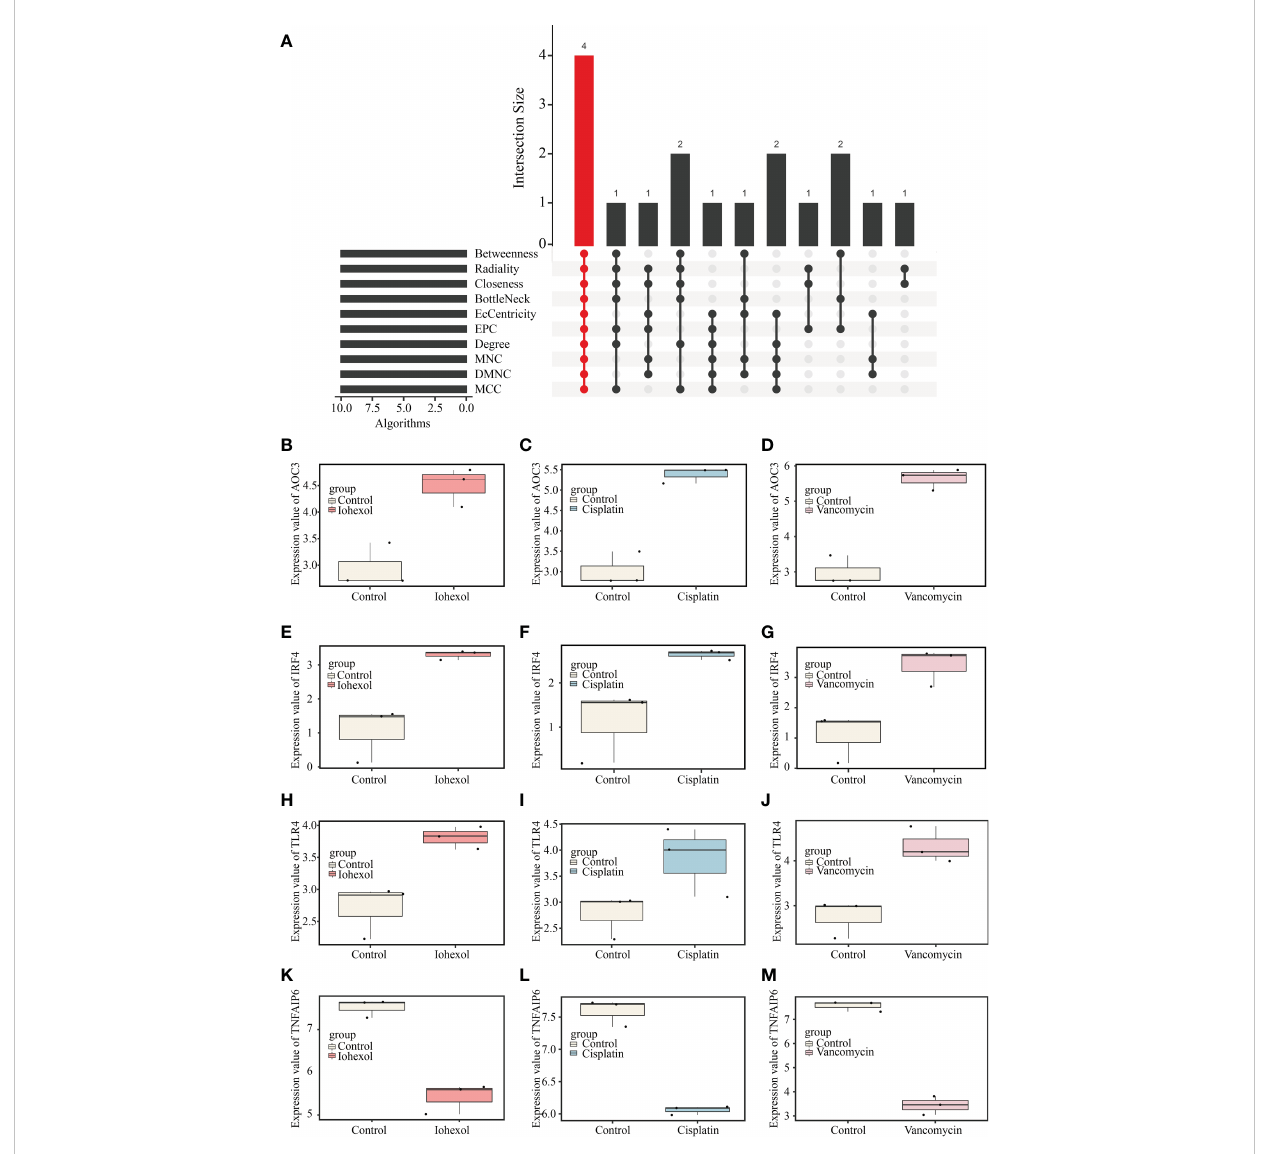
FIGURE 4 Identi fi cation of hub genes and their expression in three AKI datasets. (A) Four hub genes (AOC3, IRF4, TLR4 and TNFAIP6) were identi fi ed by intersection of co-DEGs from 10 algorithms, namely, MCC, DMNC, MNC, Degree, EPC, BottleNeck, EcCentricity, Closeness, Radiality, and Betweenness. (B – D) The expression value of AOC3 in iohexol, cisplatin or vancomycin datasets compared with controls. (E – G) The expression value of IRF4 in iohexol, cisplatin or vancomycin datasets compared with controls. (H – J) The expression value of TLR4 in iohexol, cisplatin or vancomycin datasets compared with controls. (K-M) The expression value of TNFAIP6 in iohexol, cisplatin or vancomycin datasets compared with